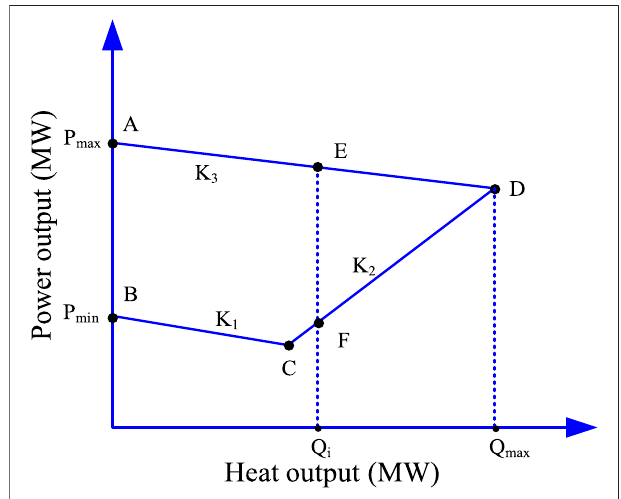
FIGURE 4 | Operation area for CHP